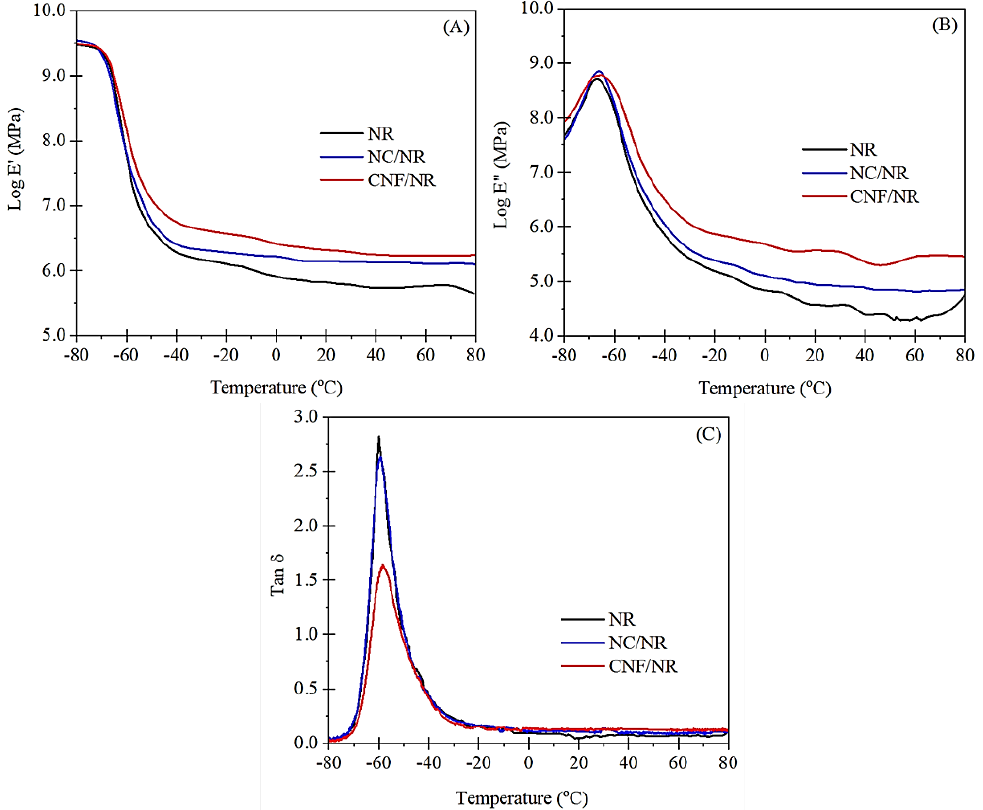
Figure 9. Variation of ( A ) storage modulus ( log E’ ), ( B ) loss modulus (log E ″ ), and ( C ) Tan δ as a function of temperature for NR, NC/NR, and CNF/NR.